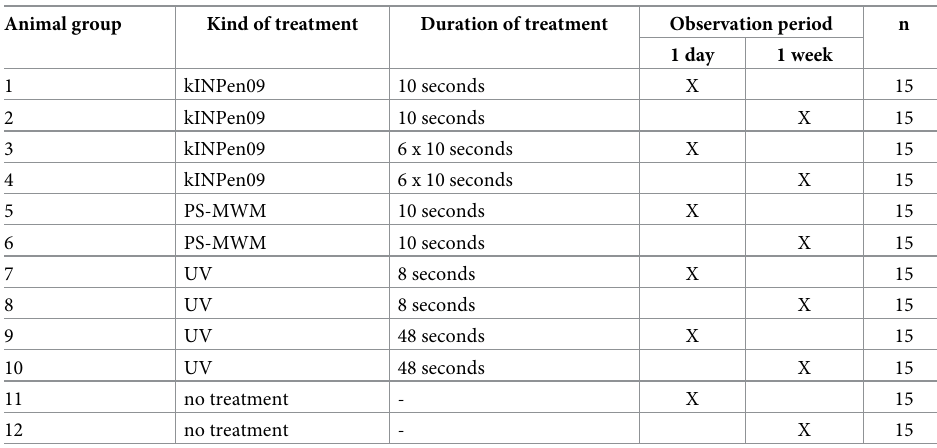
Table 1. Experimental